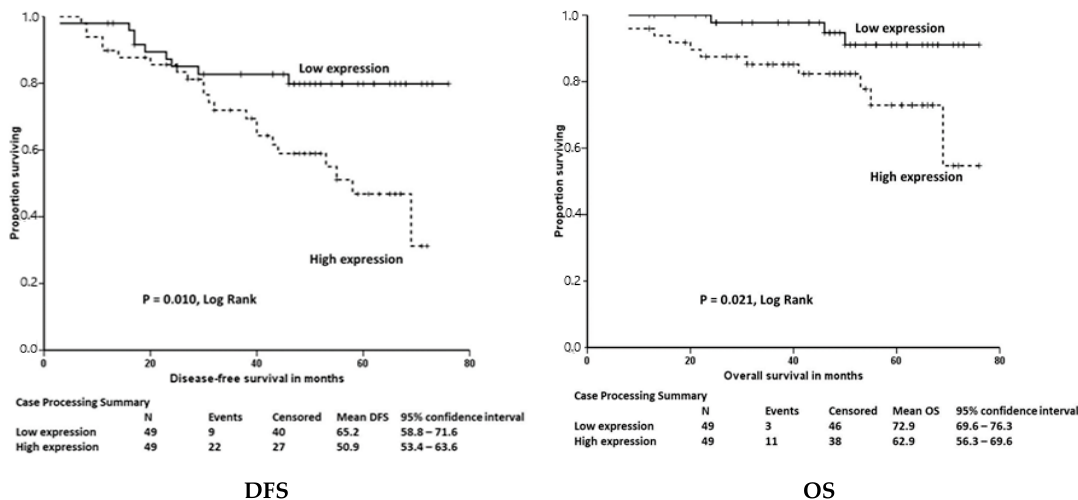
Figure 1. Association of the Selenoprotein F ( SELENOF ) gene expression with disease-free survival and overall survival, in colorectal cancer patients. Kaplan-Meier curves showing disease free survival (DFS) overall survival (OS) of 98 colorectal cancer (CRC) patients from the Czech Republic with higher SELENOF gene expression compared to low expression in tumor tissue. Subjects with higher SELENOF expression than median show poorer prognosis with shorter DFS and OS compared to subjects with lower SELENOF expression (50.9 vs. 65.2 months and 62.9 vs. 72.9 months, respectively; P DFS = 0.01 and P OS = 0.021). In multivariable Cox regression analyses adjusted by tumor stage, surgical radicality, and chemotherapy this was associated with a Hazards ratio (HR) point estimate of 2.41 for DFS (95% CI: 1.08, 5.41; P = 0.032) and 4.13 (95% CI: 1.10, 15.39; P = 0.035) for OS.